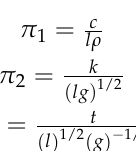
Figure 5. Geological simplified model of the Zhaoshuling Landslide event.